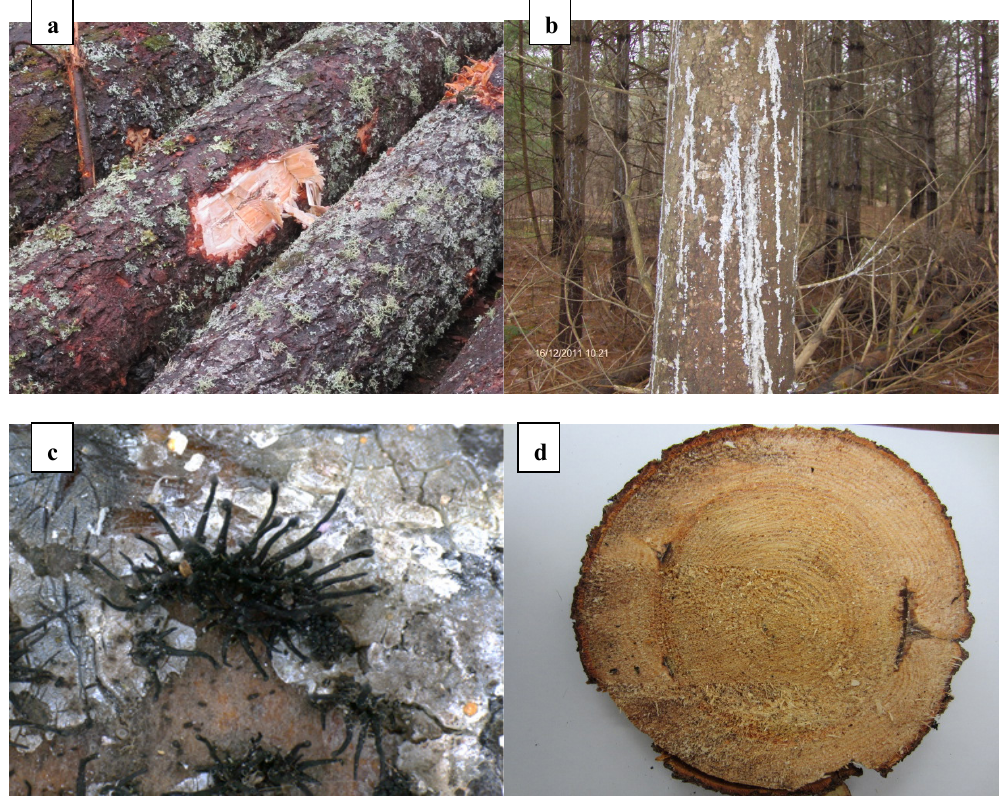
Figure 1. ( a ) Caliciopsis canker in the main stem of Pinus strobus ; ( b ) Profuse pitching resulting from Caliciopsis canker; ( c ) Ascocarps of Caliciopsis pinea , each 1–3 mm in length; ( d ) saw timber damaged by C. pinea